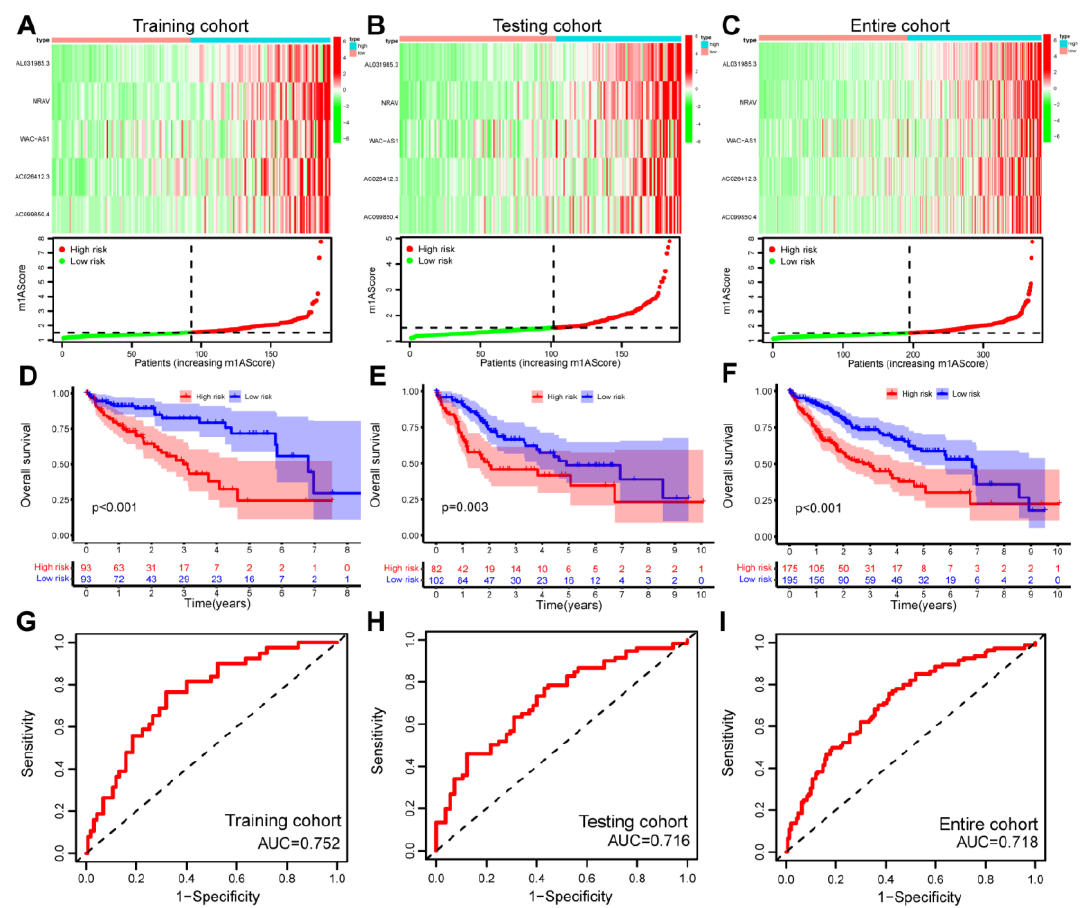
Figure 3. The prognostic values of the m1AScore. ( A – C ) Distribution of m1A-related lncRNAs and m1AScore between the high- and low-risk groups in ( A ) the training cohort, ( B ) the testing cohort, and ( C ) the entire cohort. ( D – F ) Kaplan–Meier survival curves of the overall survival of patients in the high- or low-risk groups in ( D ) the training cohort, ( E ) the testing cohort, and ( F ) the entire cohort. ( G – I ) Time-dependent ROC curve analyses in 2-year OS by m1AScore in ( G ) the training cohort, ( H ) the testing cohort, and ( I ) the entire cohort. Long noncoding RNAs, lnRNAs; Receiver operating characteristic, ROC.